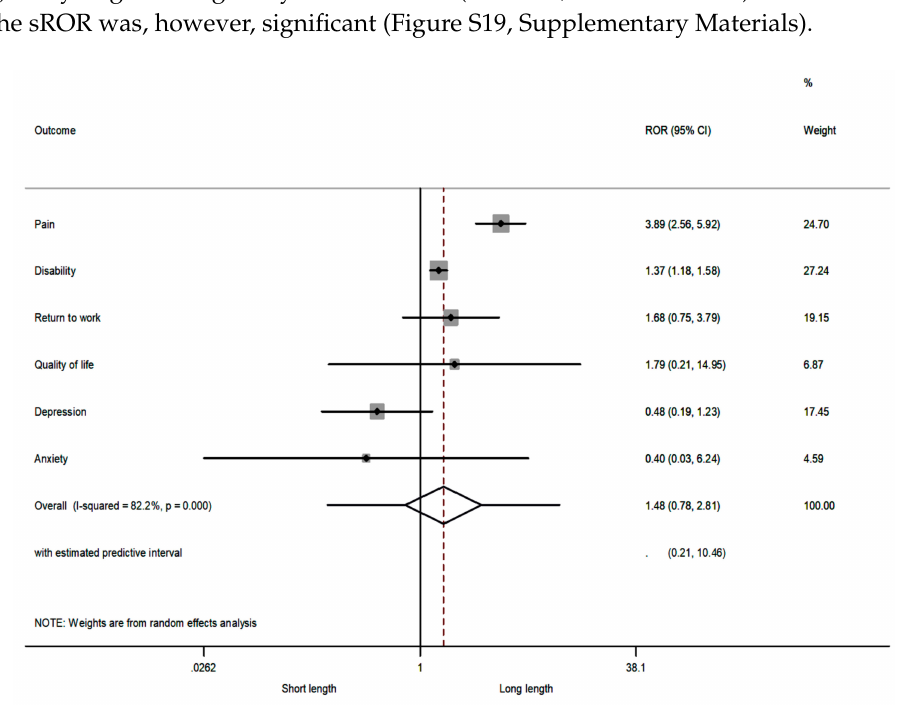
Figure 2. The relative odds ratios (RORs) and 95% confidence intervals (CIs) for each outcome, and the summary RORs and their 95% CIs at short term of a short-length treatment vs. long-length treatment. The RORs were calculated with a random-e ff ects model. A ROR > 1 favours long length; an ROR < 1 favours short